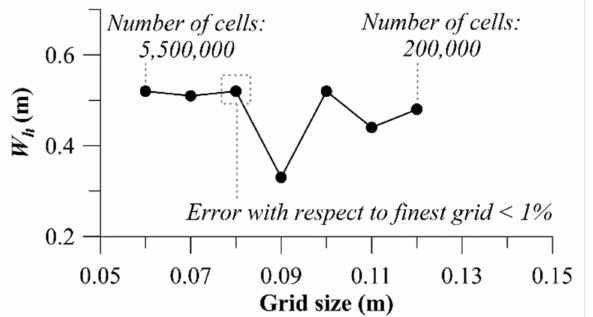
Figure 2. Variation of the wave height versus grid size of the computational mesh. (flow per unit width of the ramp = 3.5 m 2 /s, tailwater depth = 0.86 m, ramp height = 1.0 m, Kicker length = 0.75 m, kicker angle = 25 ◦